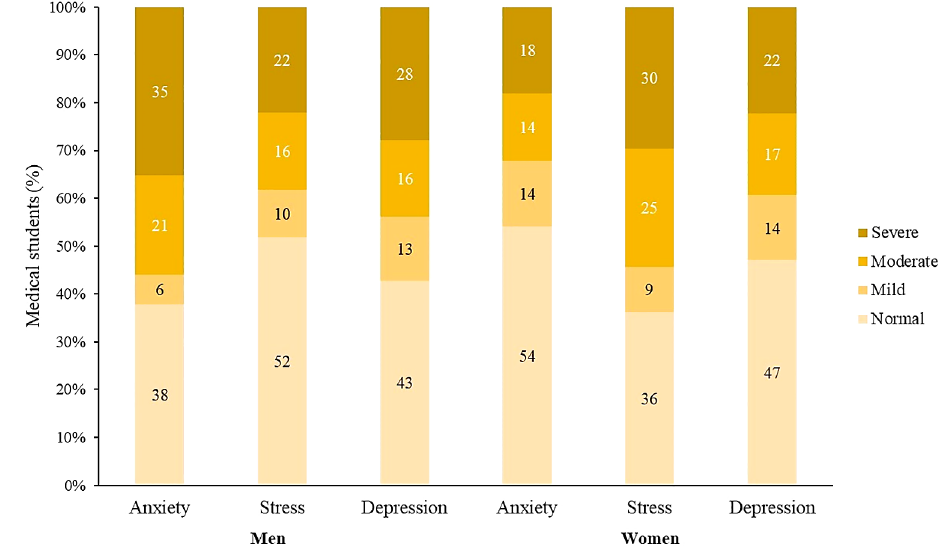
Figure 1. Distribution of psychological issues in medical